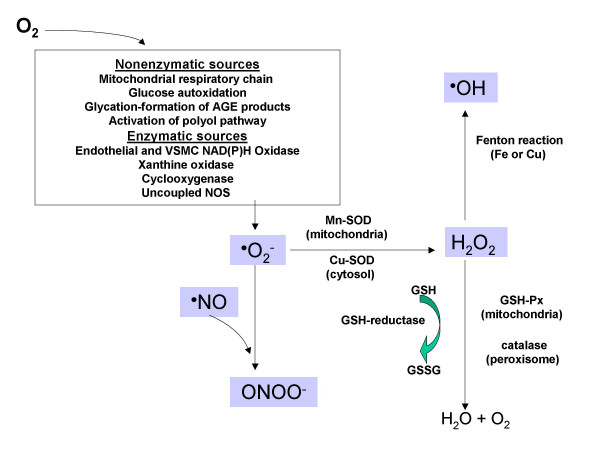
Generation of reactive species in diabetes. Highlighted in gray are some of the most important ROS and RNS in vascular cells. Oxygen is converted to •O2- via the activation of enzymatic and nonenzymatic pathways, which is then dismutated to H2O2 by SOD. H2O2 can be converted to H2O by catalase or glutathione peroxidase (GSH-Px) or to •OH after reaction with Cu or Fe. Glutathione reductase regenerates glutathione (GSH). In addition, •O2- reacts rapidly with •NO to form ONOO-.